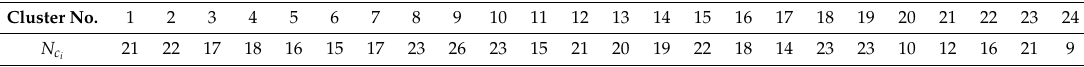
Table 3. The number of HMM states for k =